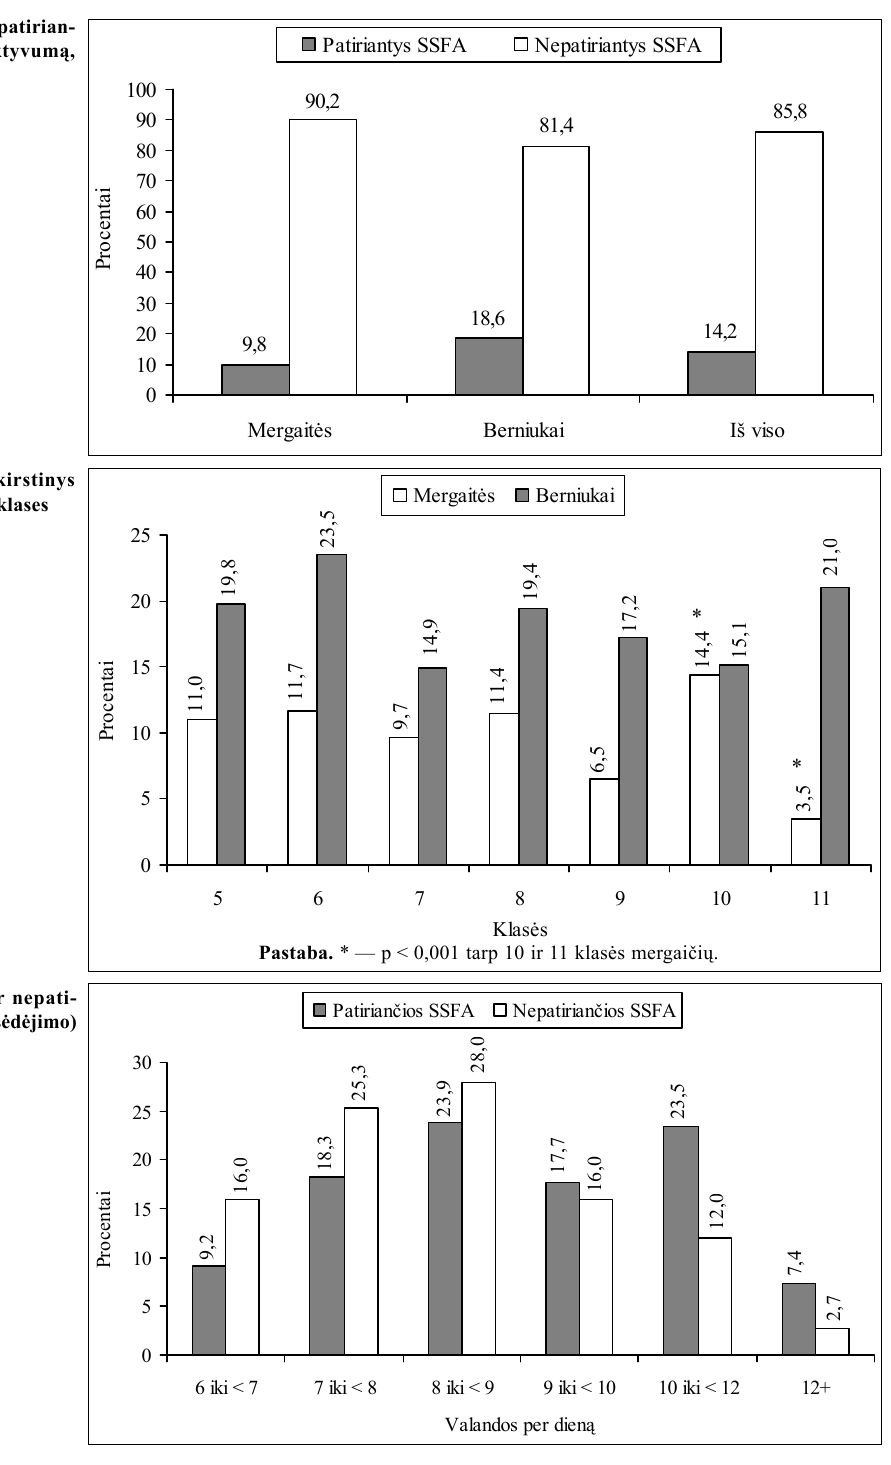
statistiškai reikšmingas fi zinio pasyvumo trukm ė s rodikli ų skirtumas nenustatytas (p > 0,05). Paly- ginus t kriterijumi nesugrupuot ą s ė d ė jimo laiko vidurk į nustatyta, kad mergai č i ų fi zinio pasyvumo trukm ė SSFA patirian č i ų grup ė je vidutiniškai yra 8,1 h / d., nepatirian č i ų j ų — 8,8 h / d. (t = 3,39; p < 0,001); berniuk ų fi zinio pasyvumo vidutin ė trukm ė SSFA patirian č i ų ir nepatirian č i ų grup ė - se — atitinkamai, 8,5 ir 8,6 h / d. (p >